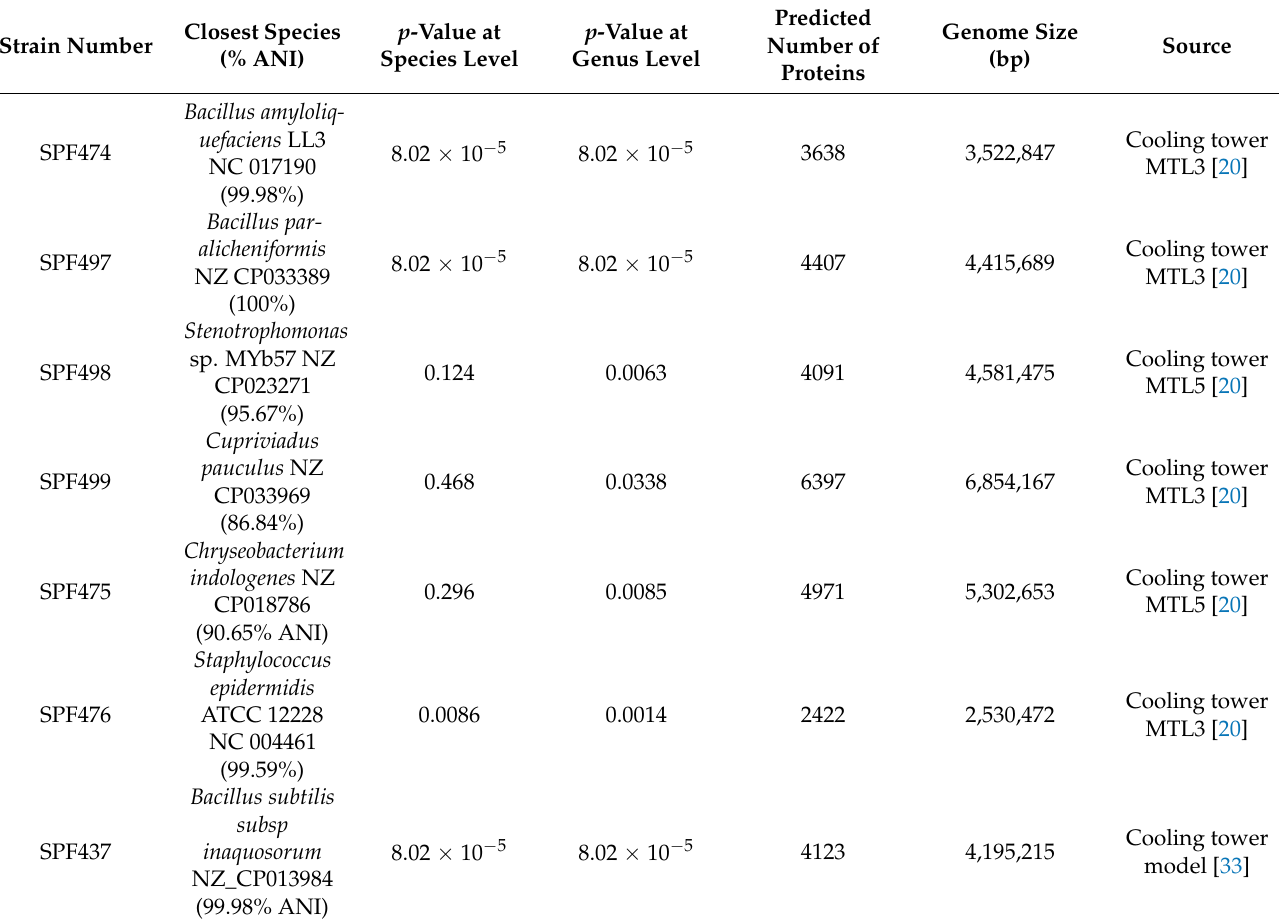
Table 2. Taxonomic classification of the anti- Legionella